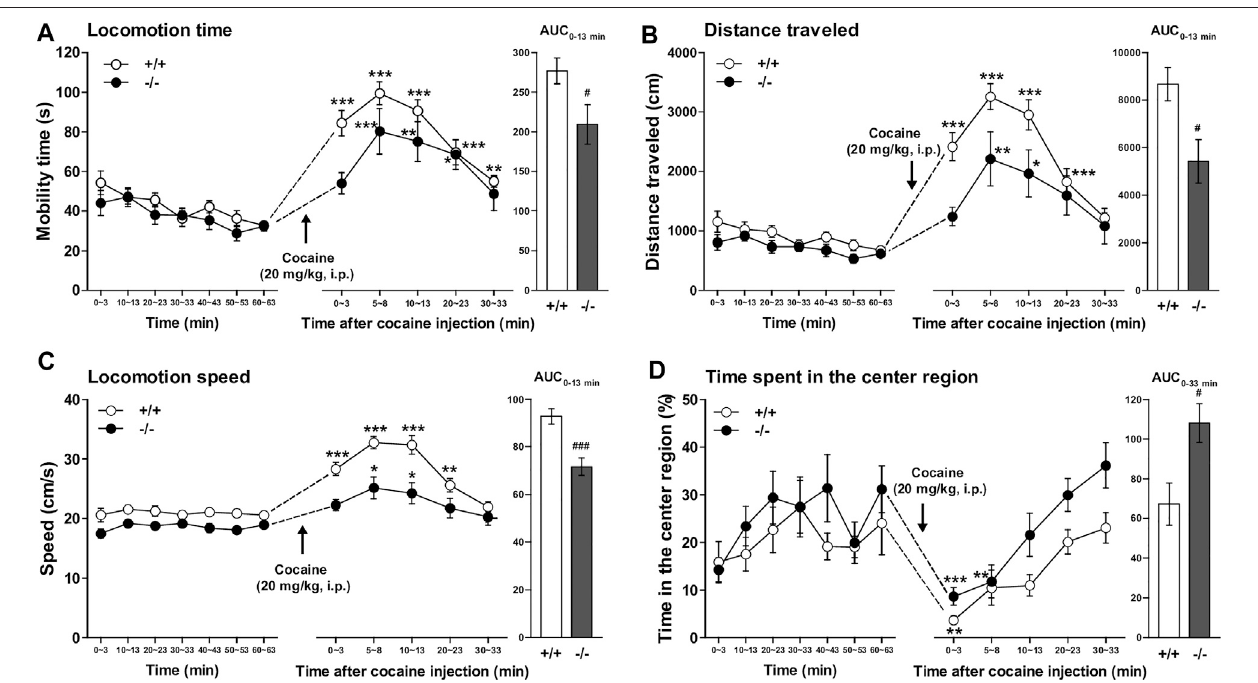
FIGURE 4 | FFAR1 − / − mice showed reduced cocaine-induced locomotor responses. Mice were placed in an open- fi eld test chamber for 63 min for habituation purpose(leftpanelsin A – D ).Then,cocainewasi.p.-injected,andmicewerereturnedtothetestchamberforanadditional33 min(middlepanelsin A – D ).Cocaineinjection (20 mg/kg, i.p.) induced signi fi cant acute enhancement of locomotor activity in both FFAR1+/+ and − / − mice. * p < 0.05, ** p < 0.01, *** p < 0.001 versus the basal (pre- cocaineinjection)values(60 – 63 mintimepoints)(Dunnett ’ stest).However,FFAR1 − / − miceshowedreducedcocaine-evokedacutelocomotorresponsesanalyzed in terms of the three parameters (right panels in A – C ), but − / − mice showed enhanced ambulation in the center region after cocaine injection (right panel in D ). Two-way ANOVAwithrepeatedmeasuresindicatedsigni fi canteffectsofgenotype[F (1,116) (cid:2) 9.32, p < 0.01 (A) ,F (1,116) (cid:2) 15.9, p < 0.001 (B) ,F (1,116) (cid:2) 43, p < 0.001 (C) ,F (1,116) (cid:2) 12.1, p < 0.001 (D) ] and time [F (5, 116) (cid:2) 18.7, p < 0.001 (A) , F (5, 116) (cid:2) 17.7, p < 0.001 (B) , F (5, 116) (cid:2) 43, p < 0.001 (C) , F (5, 116) (cid:2) 11.8, p < 0.001 (D) ]. Since signi fi